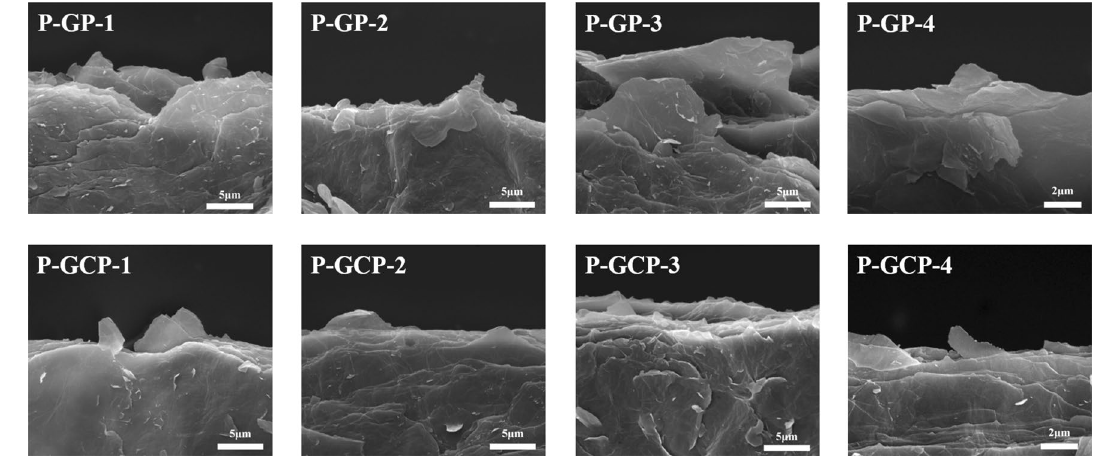
Figure 14. Fracture surface morphologies of P-GP and P-GCP artificial nacres.